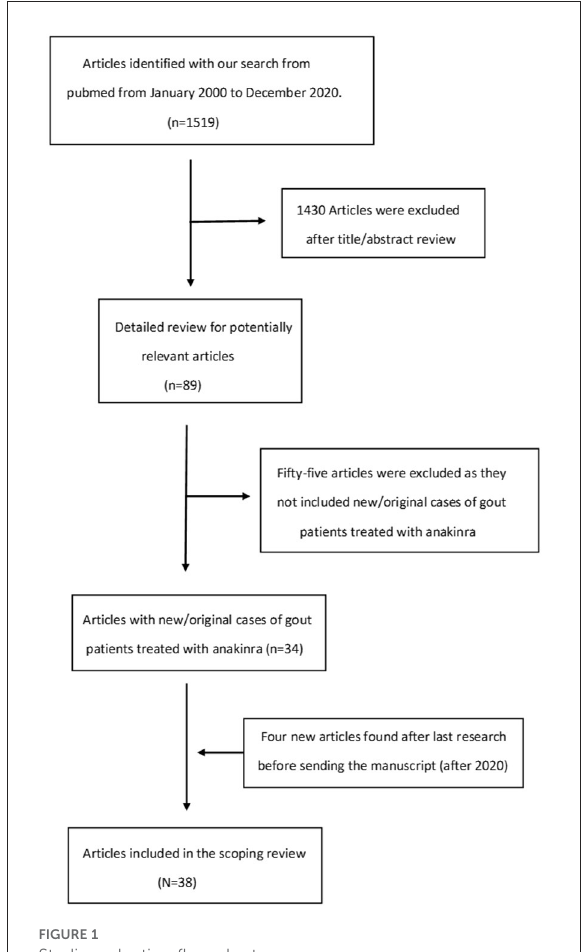
FIGURE1 Studies selection flow chart.